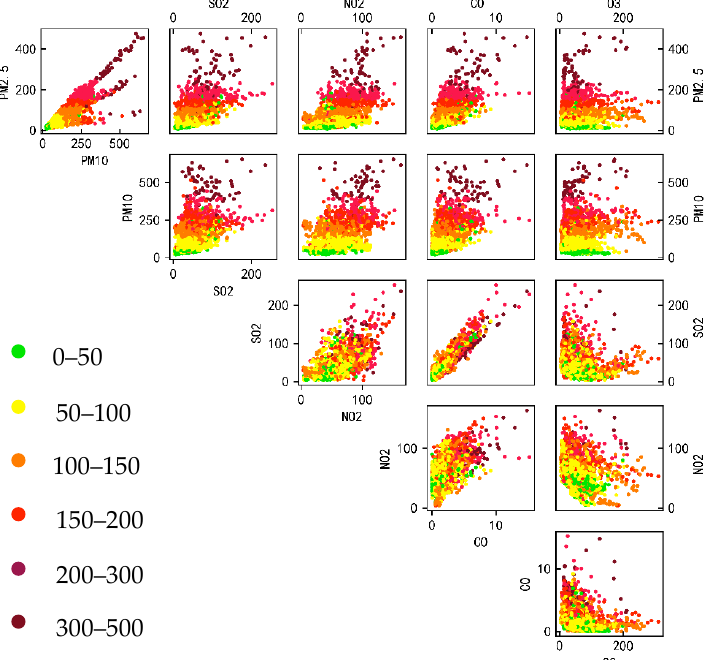
Figure 3. Correlation matrix between AQI with concentrations of six pollutants.